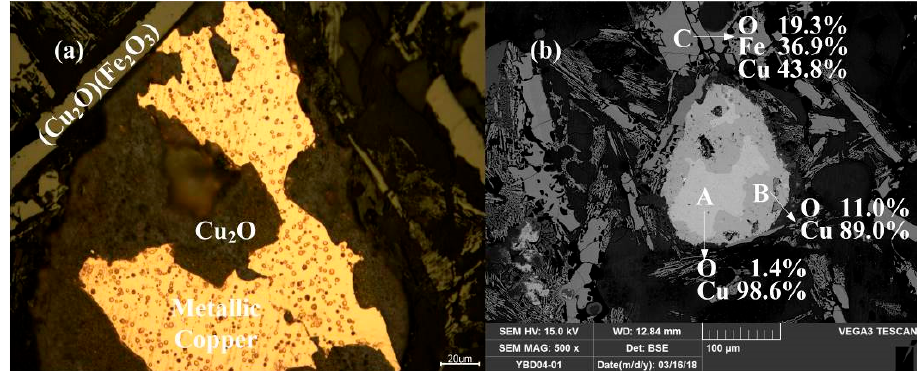
Figure 18. Optical micrograph ( a ) and SEM backscattered electron image ( b ) of YBD04. Sample YBD09: The backsca tt ered electron image at a higher magni fi cation is shown